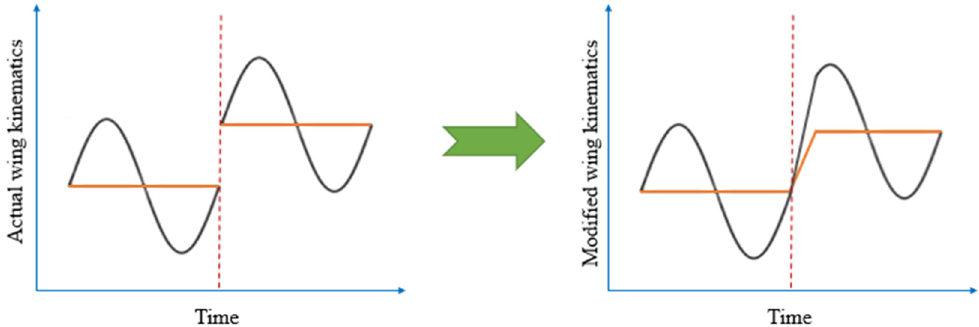
Figure 11. Discontinuity ( left ) in cycle averaged/mean inputs (frequency and wing kinematics) and modification ( right ) for its solution in nonlinear FWMAV control.